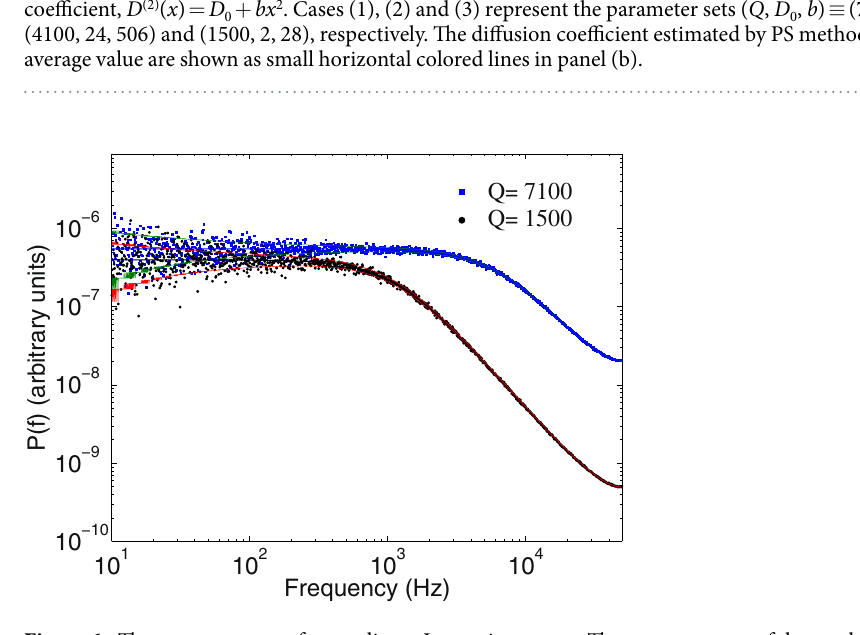
Figure 6. The power spectra of a non-linear Langevin process. The power spectra of the synthetic time series by the Langevin equation with D (1) ( x ) = − Qx and position-dependent diffusion coefficient, D (2) ( x ) = D 0 + bx 2 , with the parameter sets of ( Q , D 0 , b ) ≡ (1500, 2, 28) and (7100, 52, 1040), respectively. Solid lines represent the fit to Eq. (4), which yields (1564 ± 6, 2.2 ± 0.1, NA) and (8629 ± 13, 92.0 ± 1.9, NA),